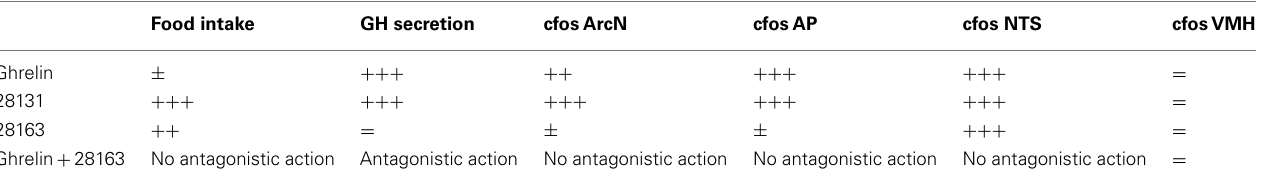
Table 3 | Summary of the effects of the different BIM compounds on GH secretion, food intake, and cFos activity in theArcN, NTS, andAP after intraperitoneal administration in the